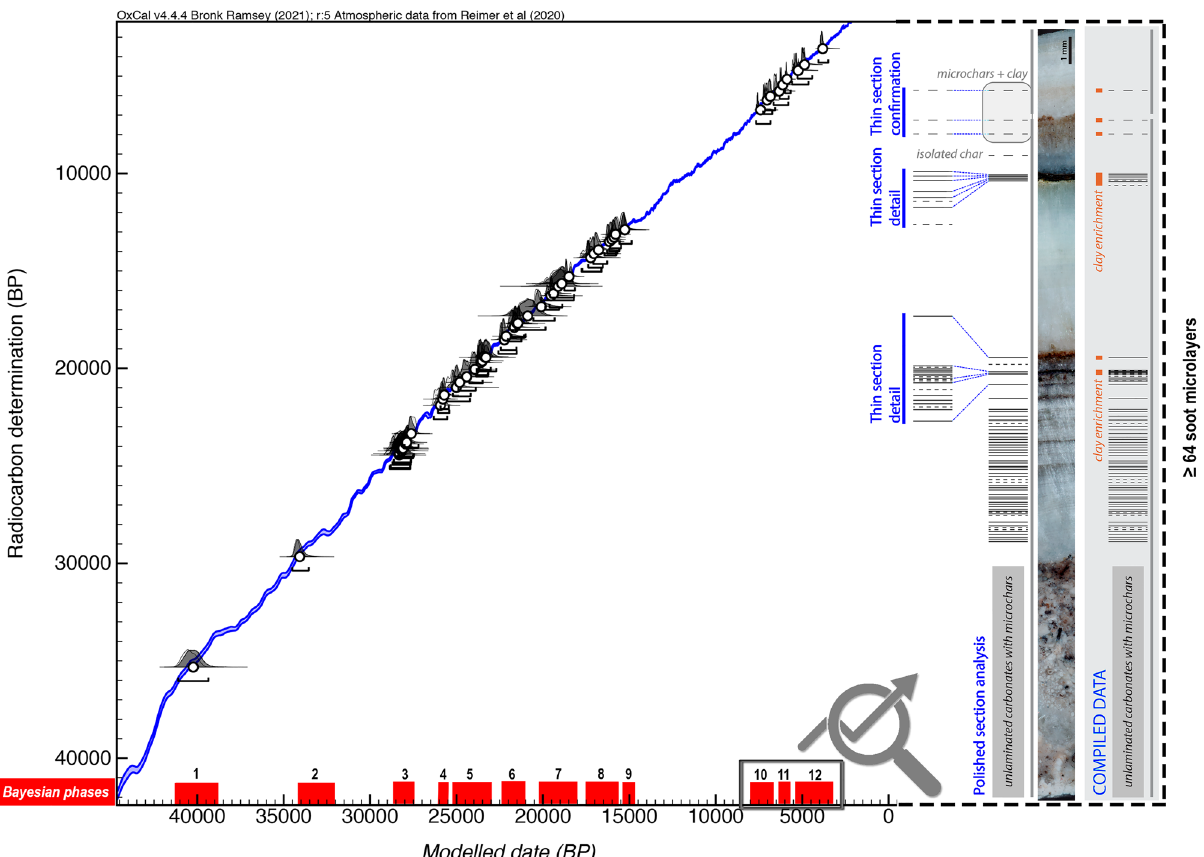
Figure 2. Curve plot with the different phases of visits to the interior of Nerja cave identified by a Bayesian model from charcoal (in red) and image of the different micro-layers of soot and micro-charcoal of the GN16- 08 stalagmite, which increase the minimum number of occupations to at least 64 for the last 3 Bayesian phases. The succession of soot films in the carbonates is represented as barcode diagrams. Bars represent soot films and dashed lines represent probable soot films. The long vertical grey line next to the barcode represents speleothem total